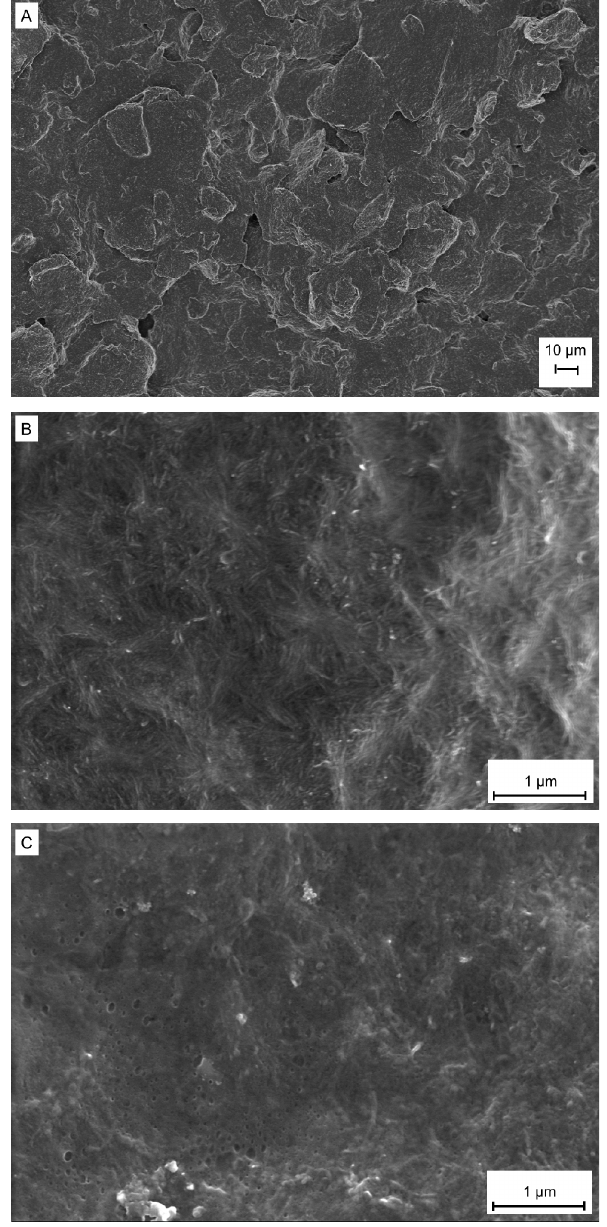
Figure 2. Field emission scanning electron microscopy (FESEM) image of the working electrode ( A ) and after modification with the chitosan / multiwalled carbon nanotubes (MWCNT) film ( B ) and before ( A ) and after modification with the chitosan/multiwalled carbon nanotubes (MWCNT) film anti-AFB1 immobilization ( C ( B ) and anti-AFB1 immobilization ( C ).